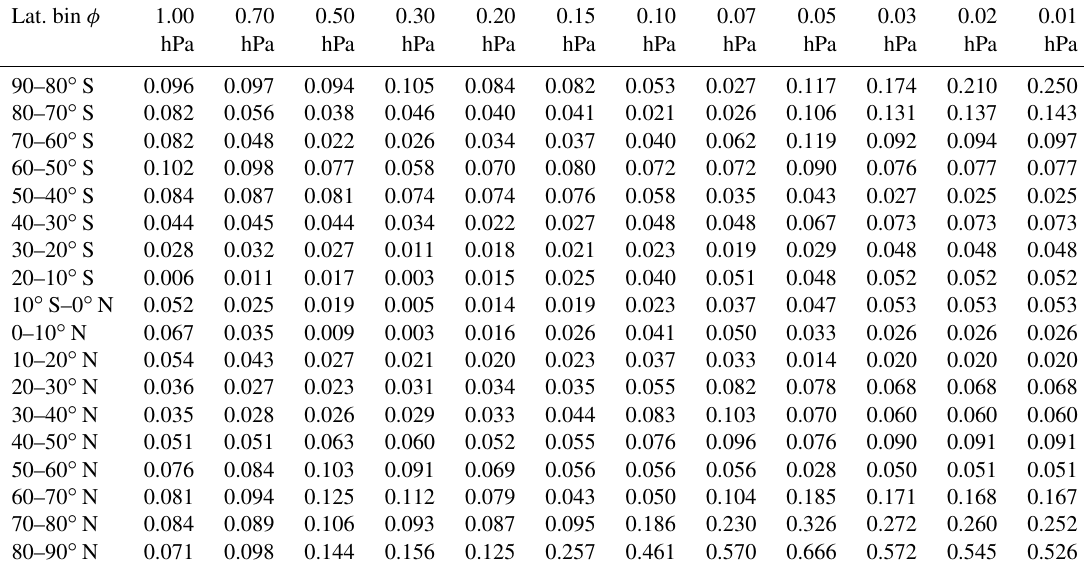
Table B4. Coefficients a 3 (φ,z)